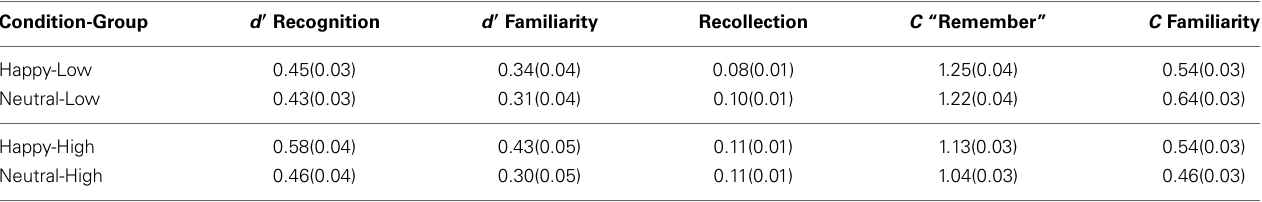
Table 2 | Recognition accuracy, familiarity, recollection, and criterion placement for participants with high or low level of prime awareness.